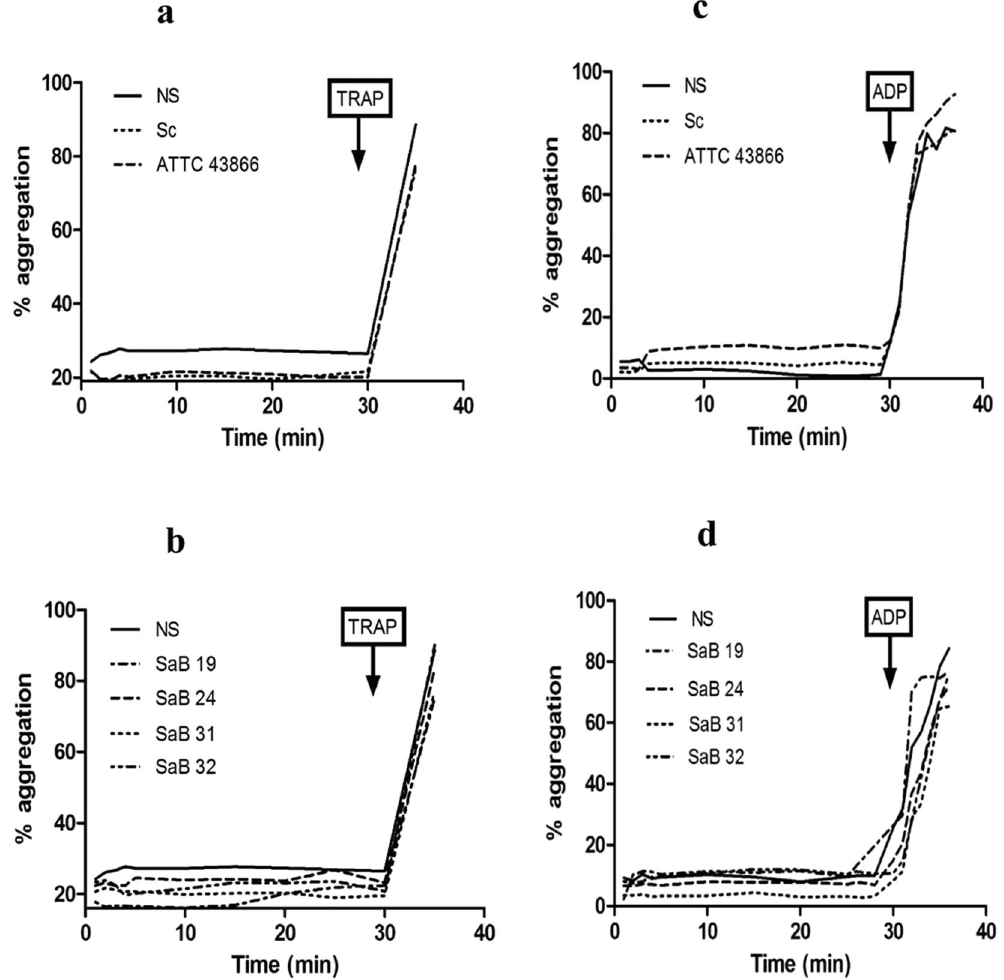
43866) or (b/d) to clinical strains (SaB). TRAP (a/b) or ADP (c/d) was added as a positive control at the end of the stimulation (one representative experiment is presented; n = 5–10 experiments). The aggregation baseline was approximately 20% due to the added